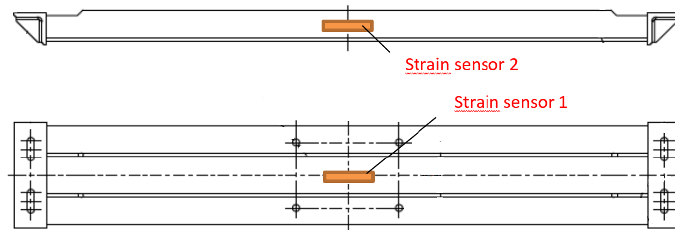
Fig. 8. Forces in the calculated model.